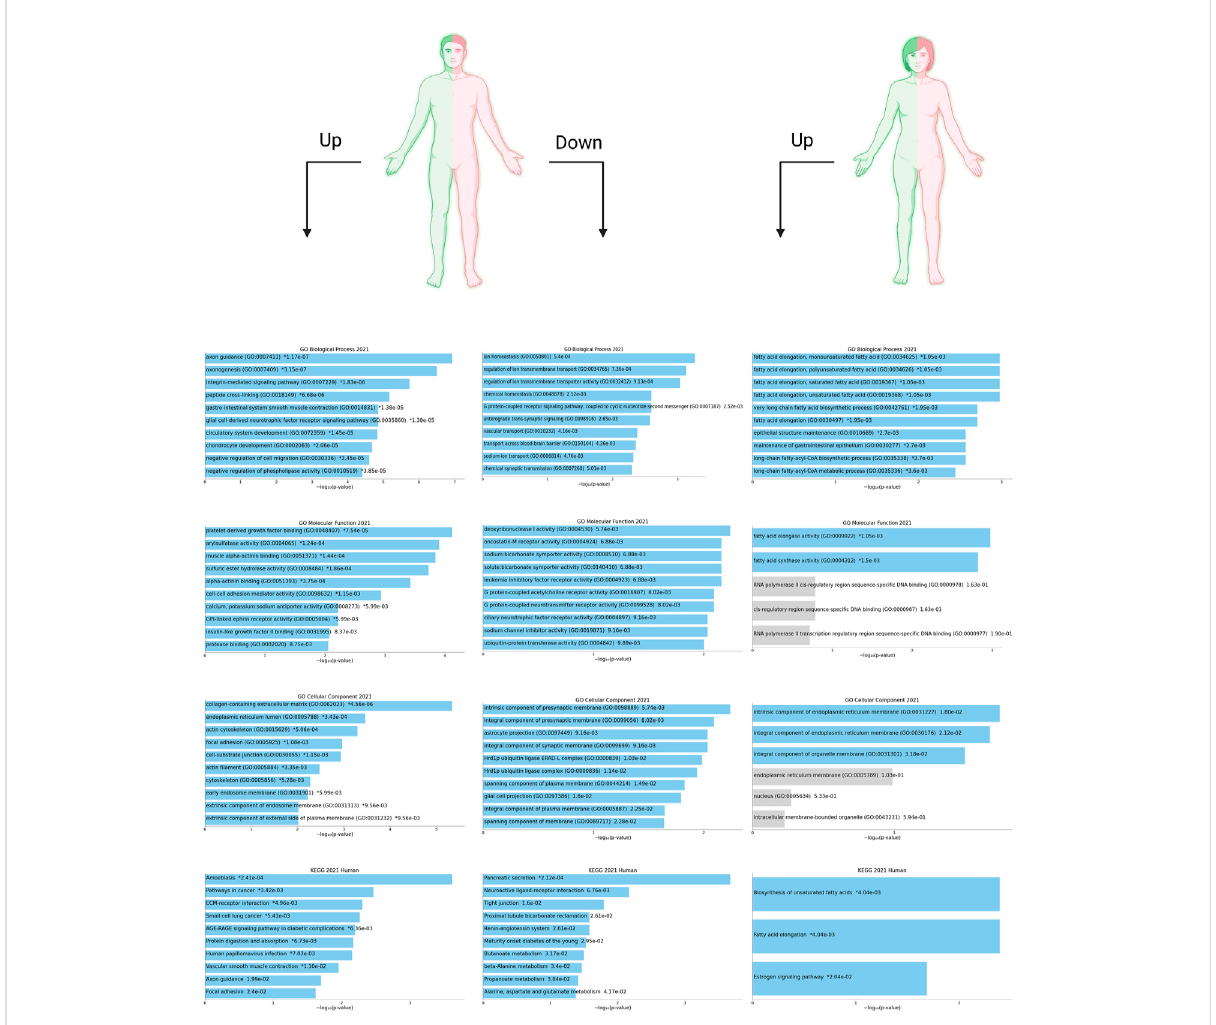
FIGURE 5 Top 10 enriched Gene Ontology (GO) terms (i.e., biological process (BP), molecular function (MF), and cellular component (CC)) and KEGG pathways have been shown for ARE-containing up- and downregulated genes (U/DRGs) in male PC patients. Also, the top enriched GO terms and KEGG pathways are listed for ERE-containing URGs in female PC patients. The corresponding p -values are shown. Blue bars correspond to terms withsigni fi cant p -values( < 0.05).Anasterisk(*)nexttoa p -valueindicatesthetermalsohasasigni fi cantadjusted p -value( < 0.05).Alldatashown here are retrieved from the Enrichr database (https://maayanlab.cloud/Enrichr/) and visualized using Enrichr